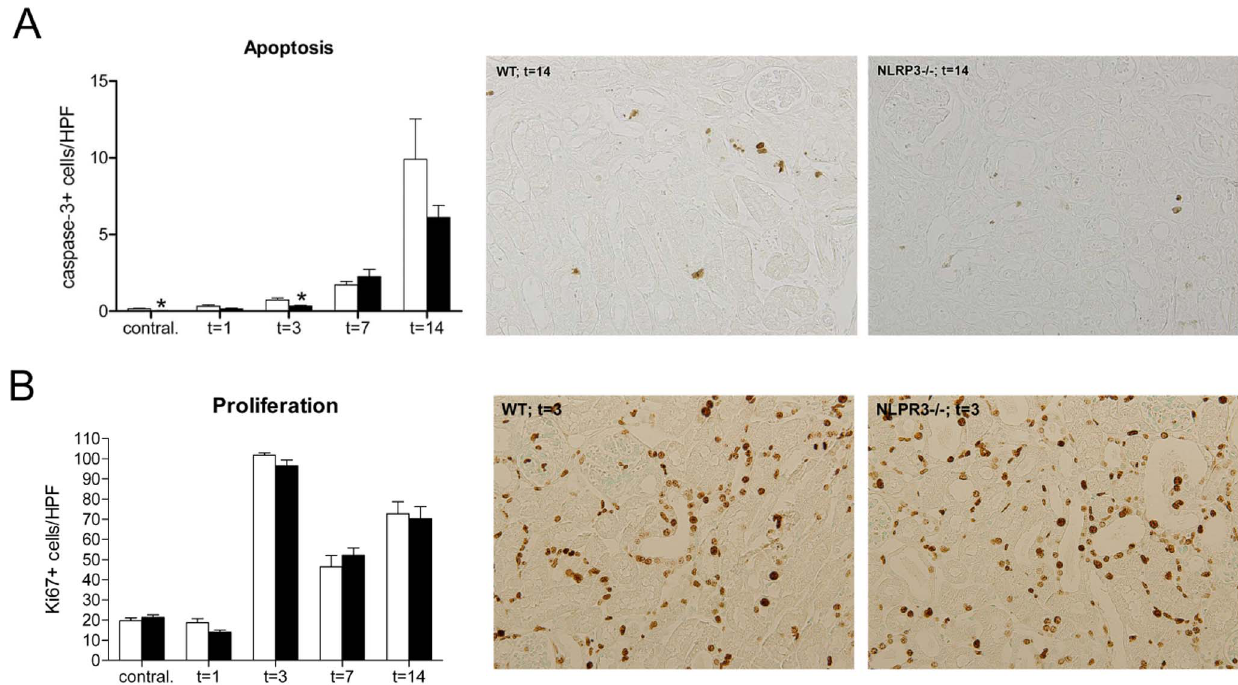
Figure 5. Nlrp3 deficiency mildly reduces number of apoptotic but not proliferating tubular epithelial cells following UUO. The number of (A) apoptotic (active caspase 3 + ) TECs was mild but significantly lower in contralateral and 3-day obstructed kidneys of Nlrp3 2 / 2 (black bars) mice compared to wild type mice (white bars), whereas at other time points no differences were observed. (B) The number of proliferating TECs was comparable between wild type and Nlrp3 2 / 2 mice at all time points. Data are mean 6 SEM of 7 mice per group. Contral. = contralateral kidneys of mice subjected to 14 days of UUO. *:p , 0.05. The panels show representative microphotographs of renal tissue sections, magnification x200.